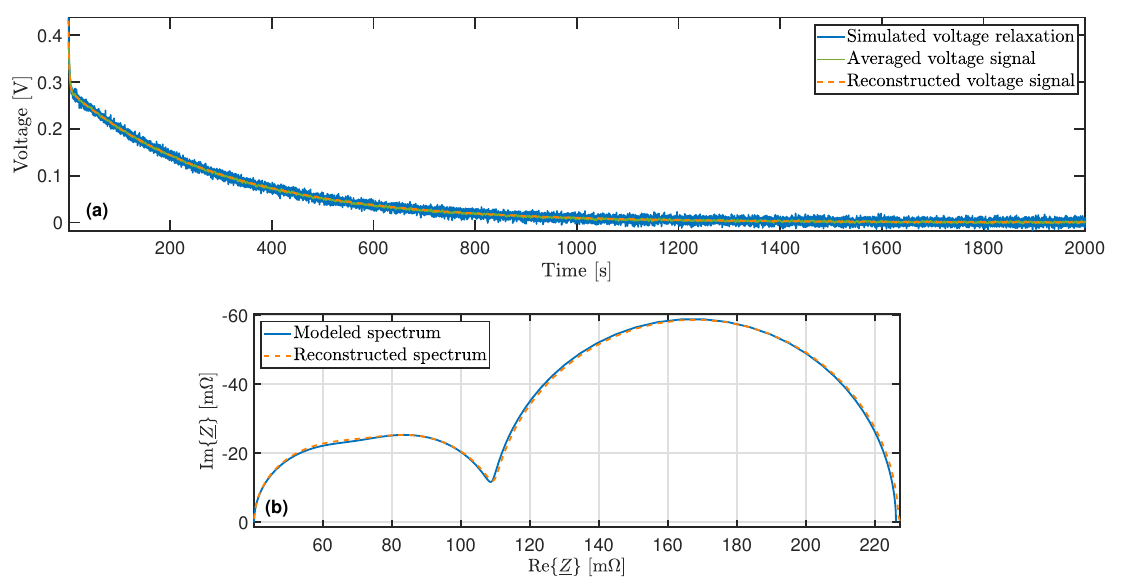
Figure 3. ( a ) Comparison of simulated and reconstructed voltage during the relaxation period. ( b ) Comparison of modeled and reconstructed impedance